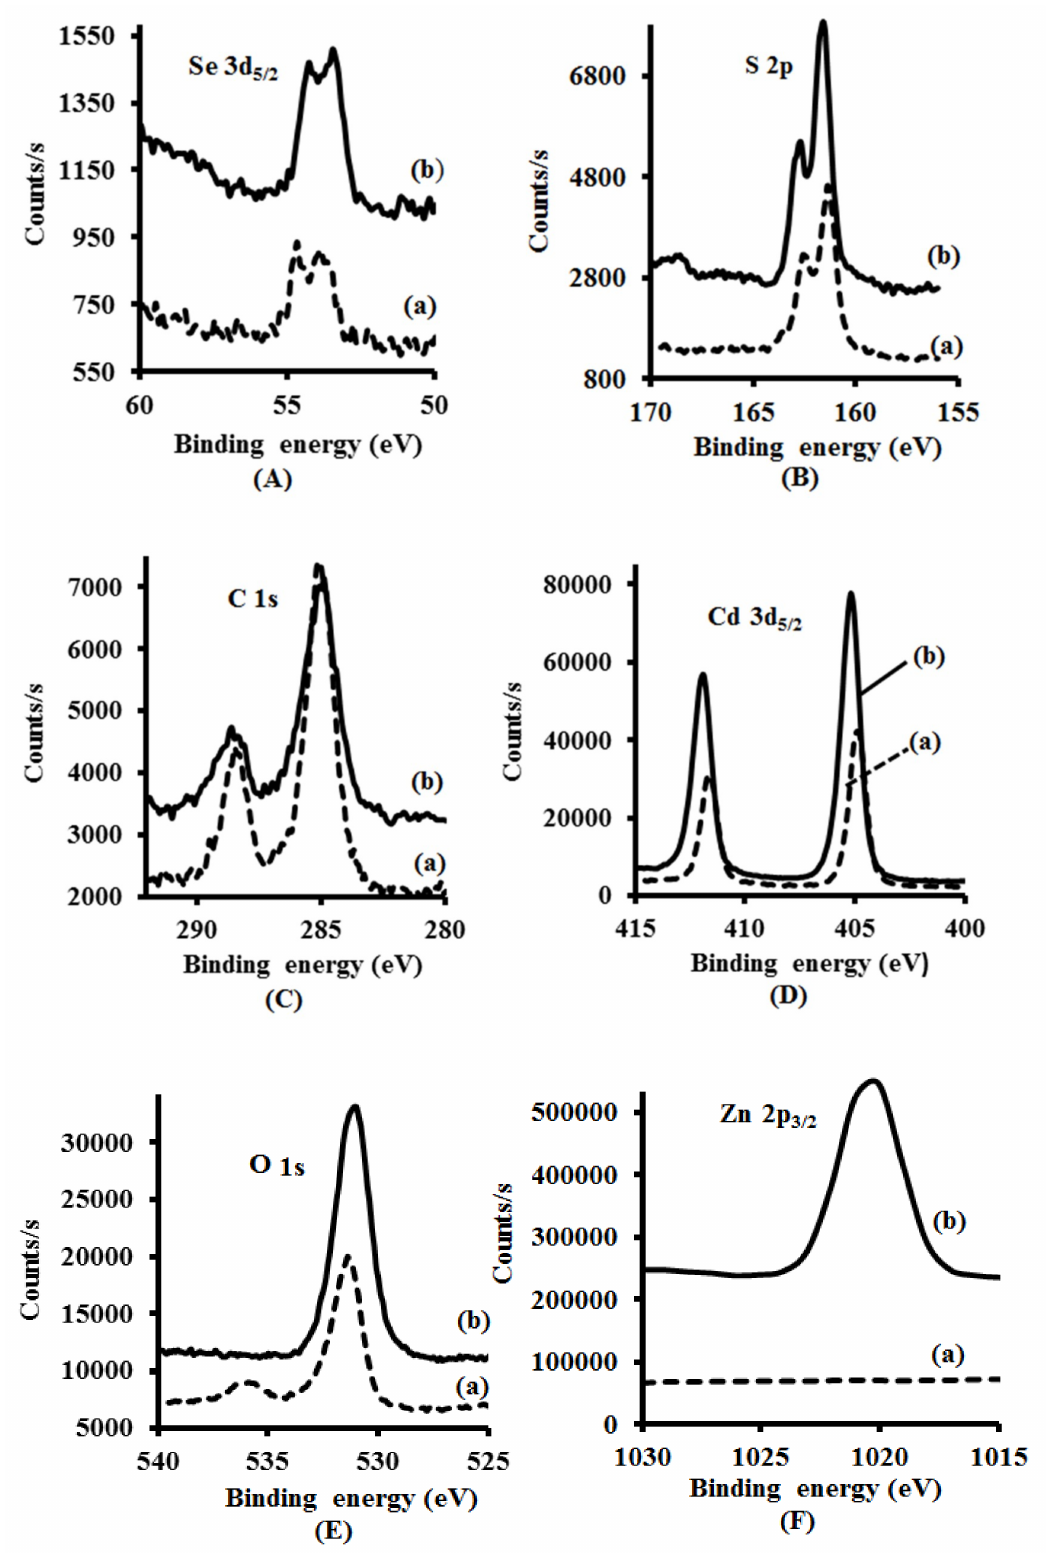
Figure 4. XPS spectra of QDs: ( a ) CdSe(S) and ( b ) CdSe(S)/ZnO QDs: Binding energy of ( A ) Se 3d , ( B ) S 2p , ( C ) C 1s , ( D ) Cd 3d , ( E ) O 1s , and ( F ) Zn 2p